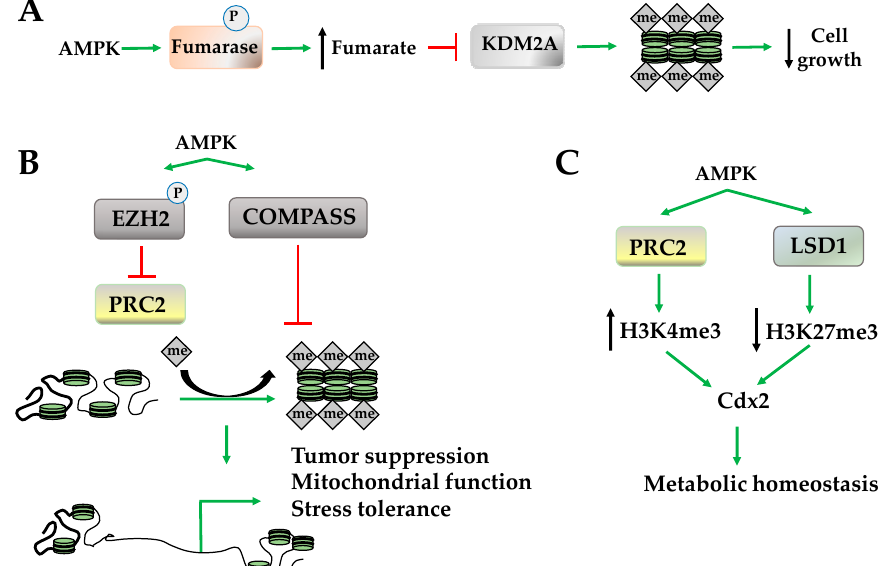
Figure 4. AMPK regulates histone methylation. ( A ) AMPK phosphorylates fumarase increase fumarate, which inhibits lysine-specific demethylase 2A (KDM2A), increasing histone methylation at cell growth; ( B ) AMPK decreases histone methylation through inhibition of polycomb repressive complex 2 (PRC2) and complex proteins associated with set1 (COMPASS complex); ( C ) AMPK modulates histone 3 methylations status to increase caudal type homeobox2 [cell differentiation]) (Cdx2) expression and metabolic homeostasis. LSD1: lysine-specific histone demethylase-1; EZH2: zeste homolog 2.